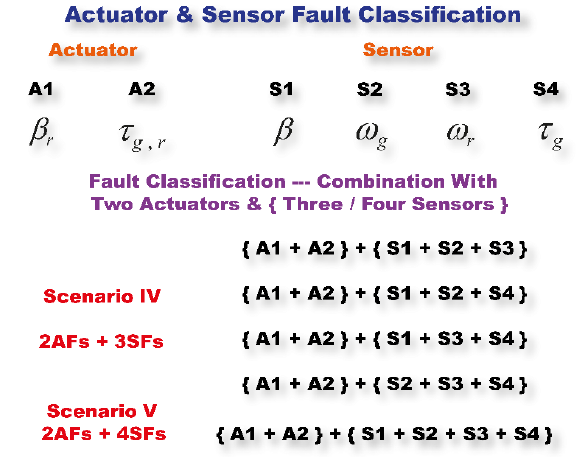
Figure 8. Experimentation design for actuator and sensor fault classification, under Scenario IV (2AFs + 3SFs) and Scenario V (2AFs + 4SFs).